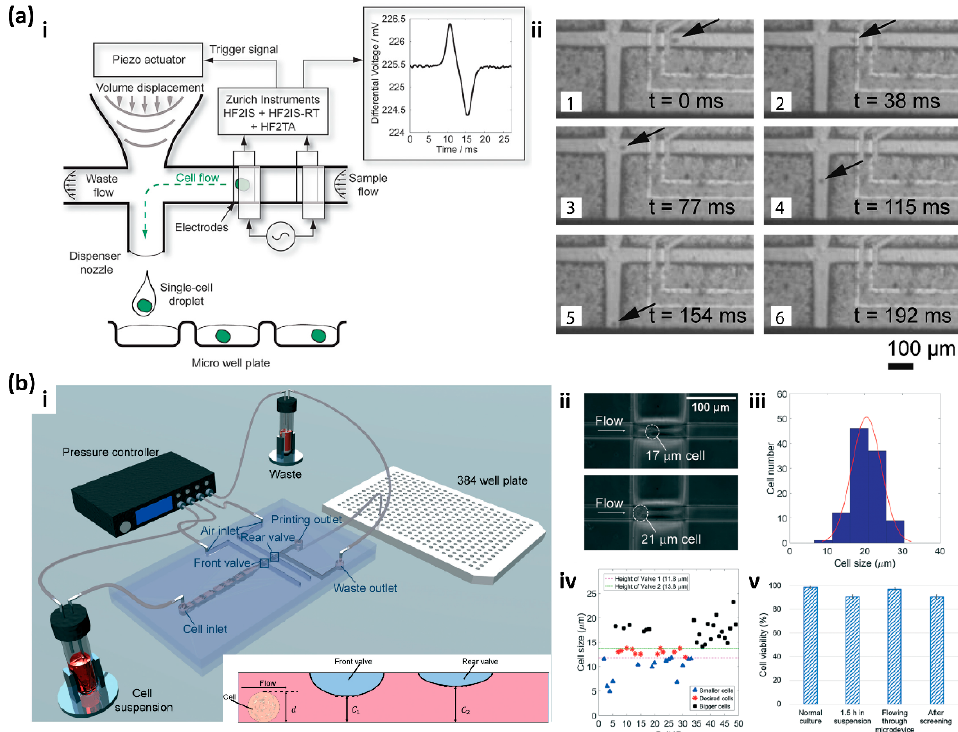
Figure 4. ( a-i ) Schematic illustration of the mechanism of the impedance-based single-cell printing system. The impedance signals of the flow-through cells trigger the actuator to generate and dispense the droplets containing single cells. ( a-ii ) The time-lapse images show the progress of printing a single HeLa cell. Reproduced with permission from [42]. ( b-i ) Schematic illustration of the system and mechanism of the dual microvalves-based single-cell screening and printing. ( b - ii ) HUVECs were captured by the valves under the pressure of 0.8 atm. ( b - iii ) the size distribution of the HUVECs’ suspension. ( b - iv ) the size of HUVECs screened by the valves. ( b - v ) Cell viability with different conditions. Reproduced with permission from [99].